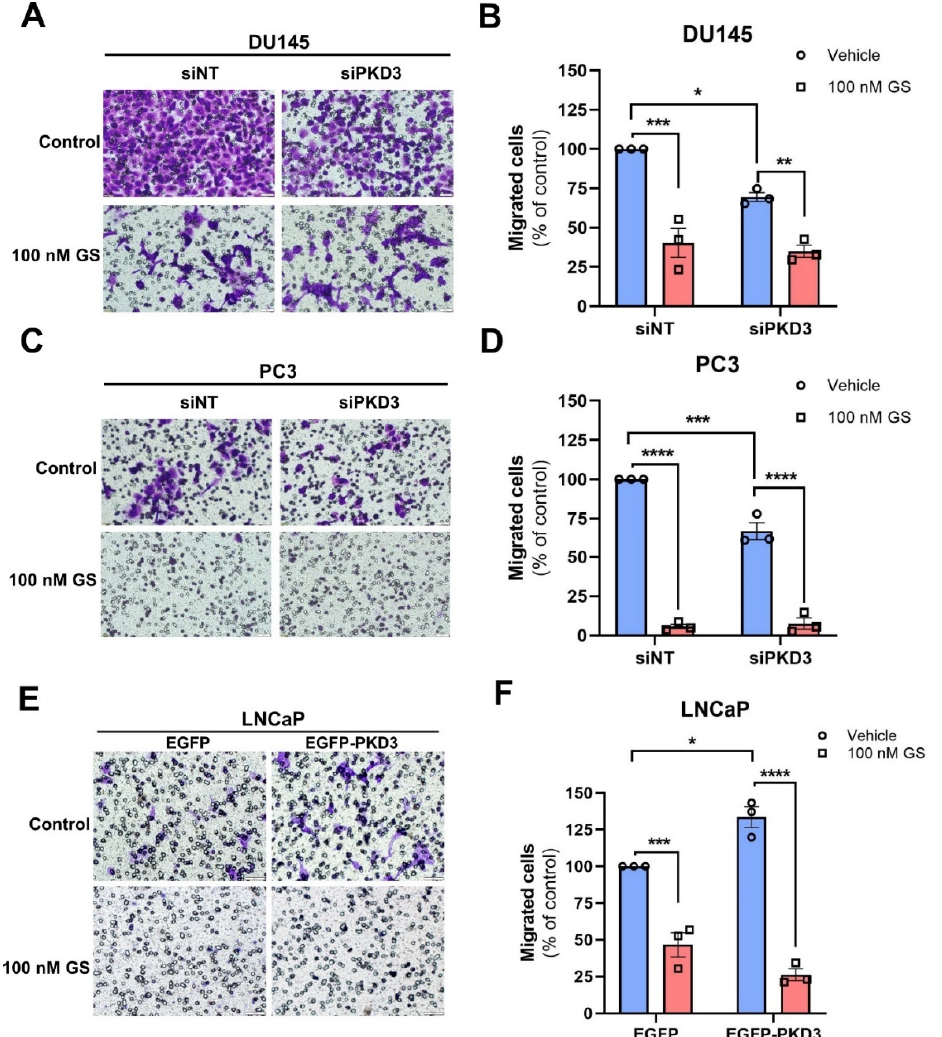
Figure 5. Stabilization of PKD3 by Hsp90 is essential for prostate cancer cell migration. Representative microscope images of DU145 ( A ) and PC3 ( C ) cell migration in response to PKD3 gene silencing and/or ganetespib (GS) treatment. Quantification of the results (mean ± SEM) obtained with DU145 ( B ) and PC3 ( D ) cells from panels ( A , C ). Cells were PKD3 silenced by specific siRNAs for 48 h, then cell motility was investigated in the absence or presence of 100 nM GS for 22 h. ( E ) Representative microscope image of LNCaP cell migration in response to PKD3 gene transfection and/or GS treatments. Quantification of the results (mean ± SEM) from panel ( F ). LNCaP cells were transfected with EGFP or EGFP–PKD3 expressing vectors for 24 h, then cell migration was investigated in the absence or presence of GS for 24 h. Scale bars represent 50 µm. All data are from 3 independent experiments. * p < 0.05, ** p < 0.01, *** p < 0.001, **** p < 0.0001, (one-way ANOVA with Dunett’s multiple comparison test).